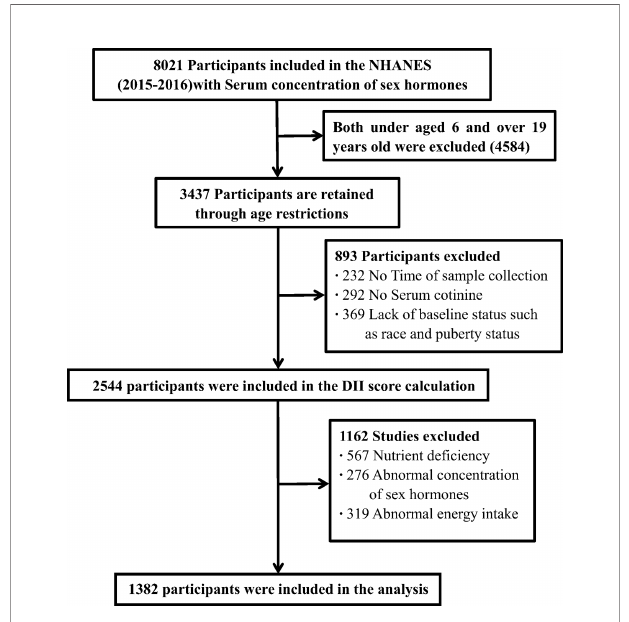
FIGURE 1 | Flowchart of the sample selection in NHANES